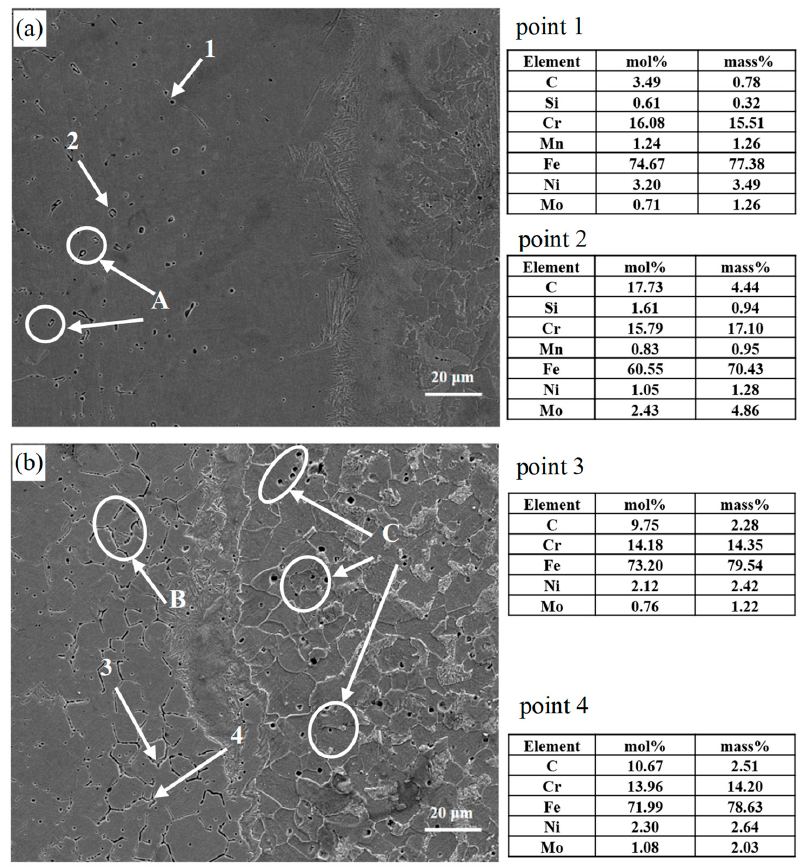
Figure 3. SEM images and EDS analysis of samples: ( a ) EDS results of points 1 and 2 in as-deposited materials, ( b ) EDS results of points 3 and 4 in rolled materials.